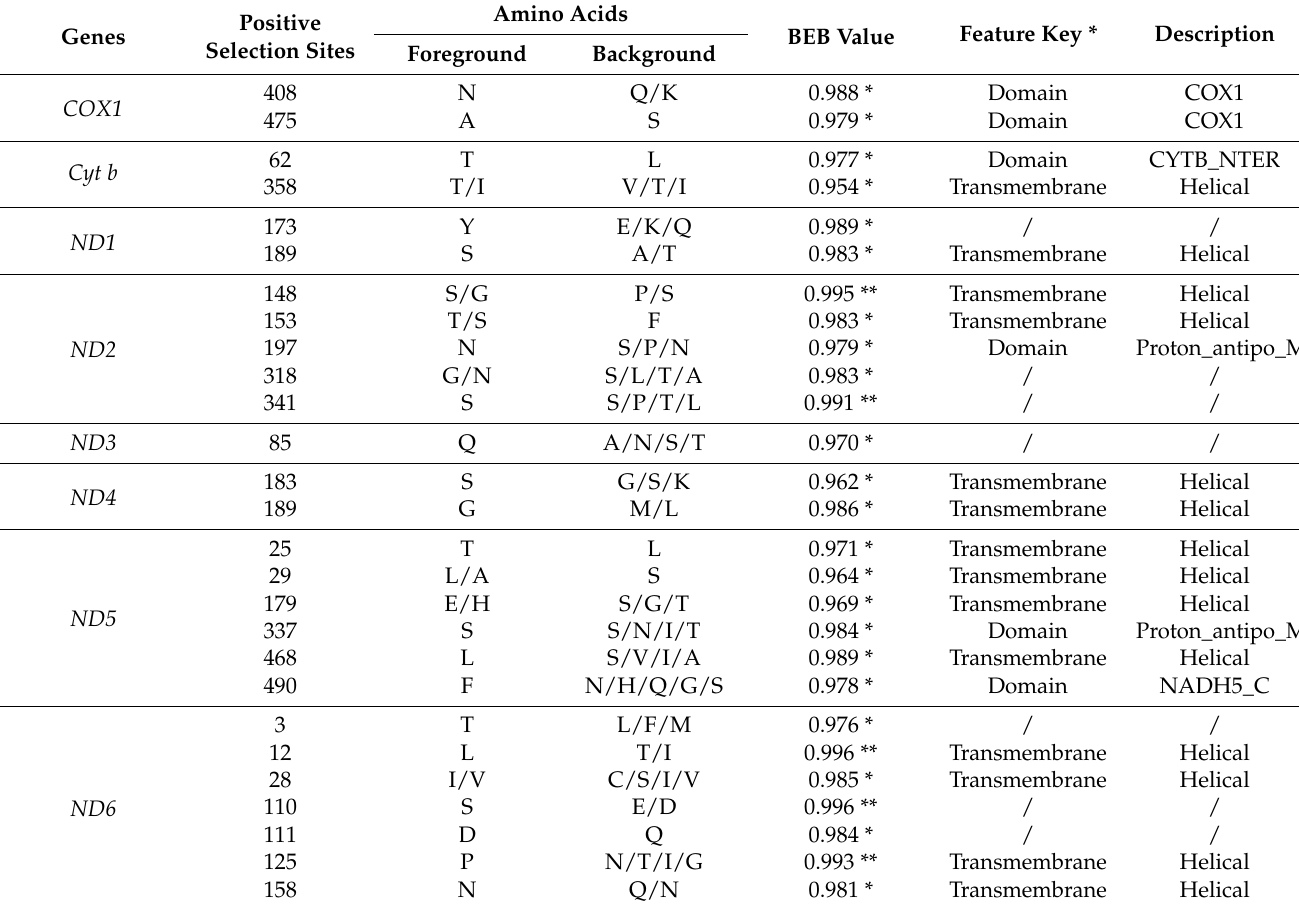
Table 5. The features and description of the positive selection sites detected in the mitochondrial PCGs of Heptageni- idae